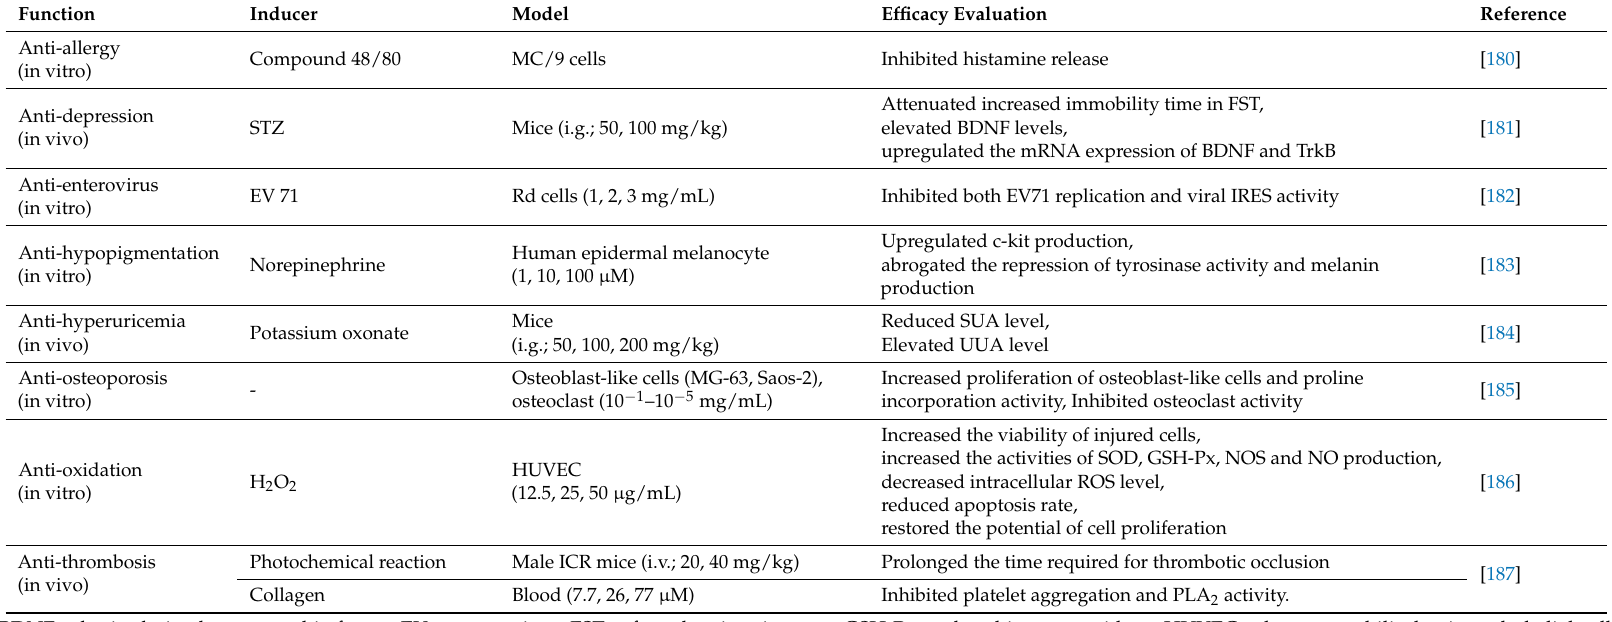
Table 3. Other pharmacological effects of